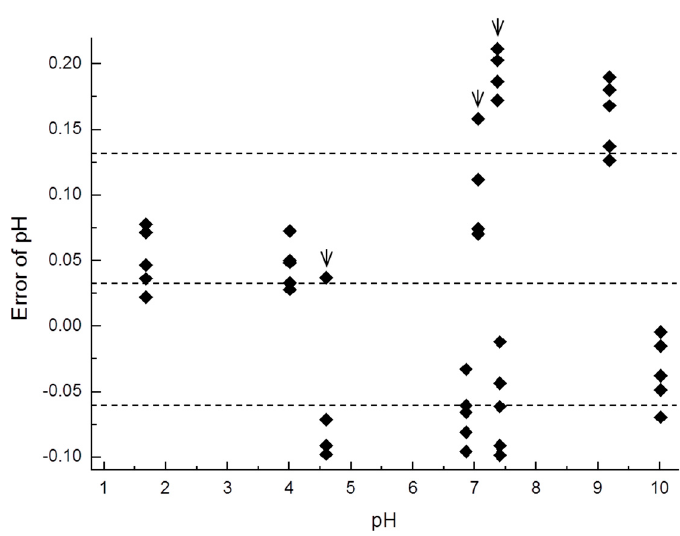
Figure 9. The error distribution of six standard solutions and three diluted solutions (with arrow) measured by the present system. The measurement error was 0.0343 ± 0.0974 pH (average error ± S.D., n = 42). The dotted lines show the average error and S.D. Table 1. pH measurement error using the present system